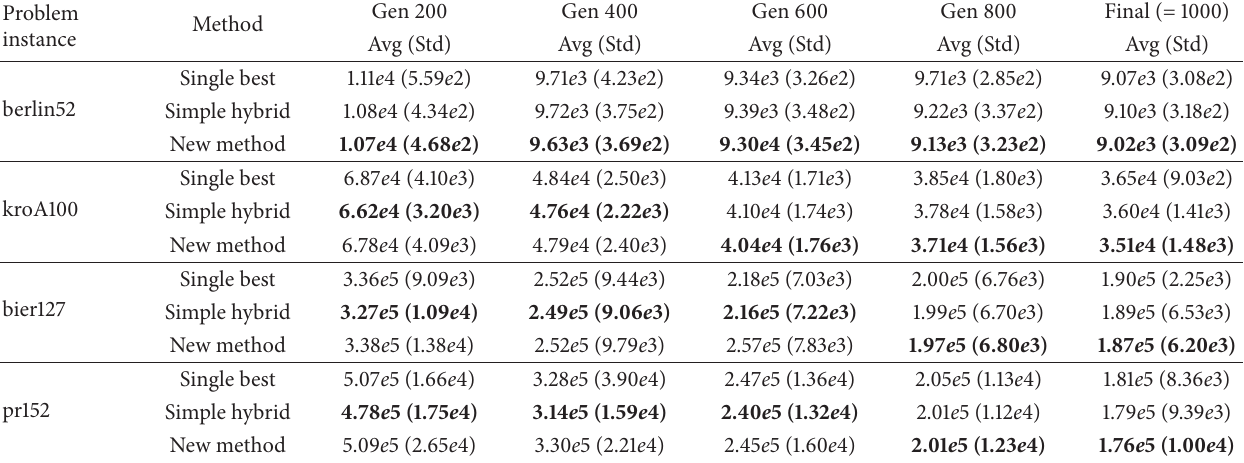
Table 2: Results of TSP.